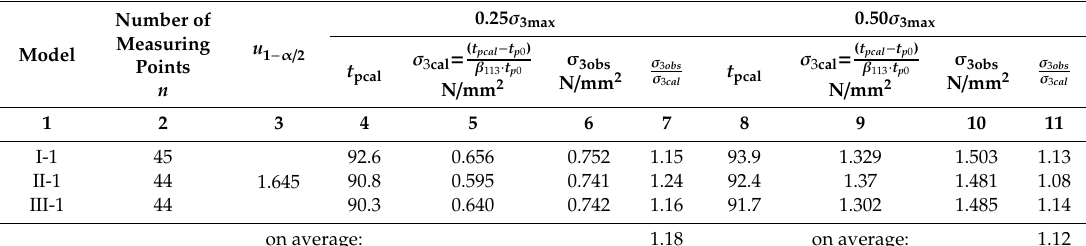
Table 7. Compared results from tests and upper values of confidence